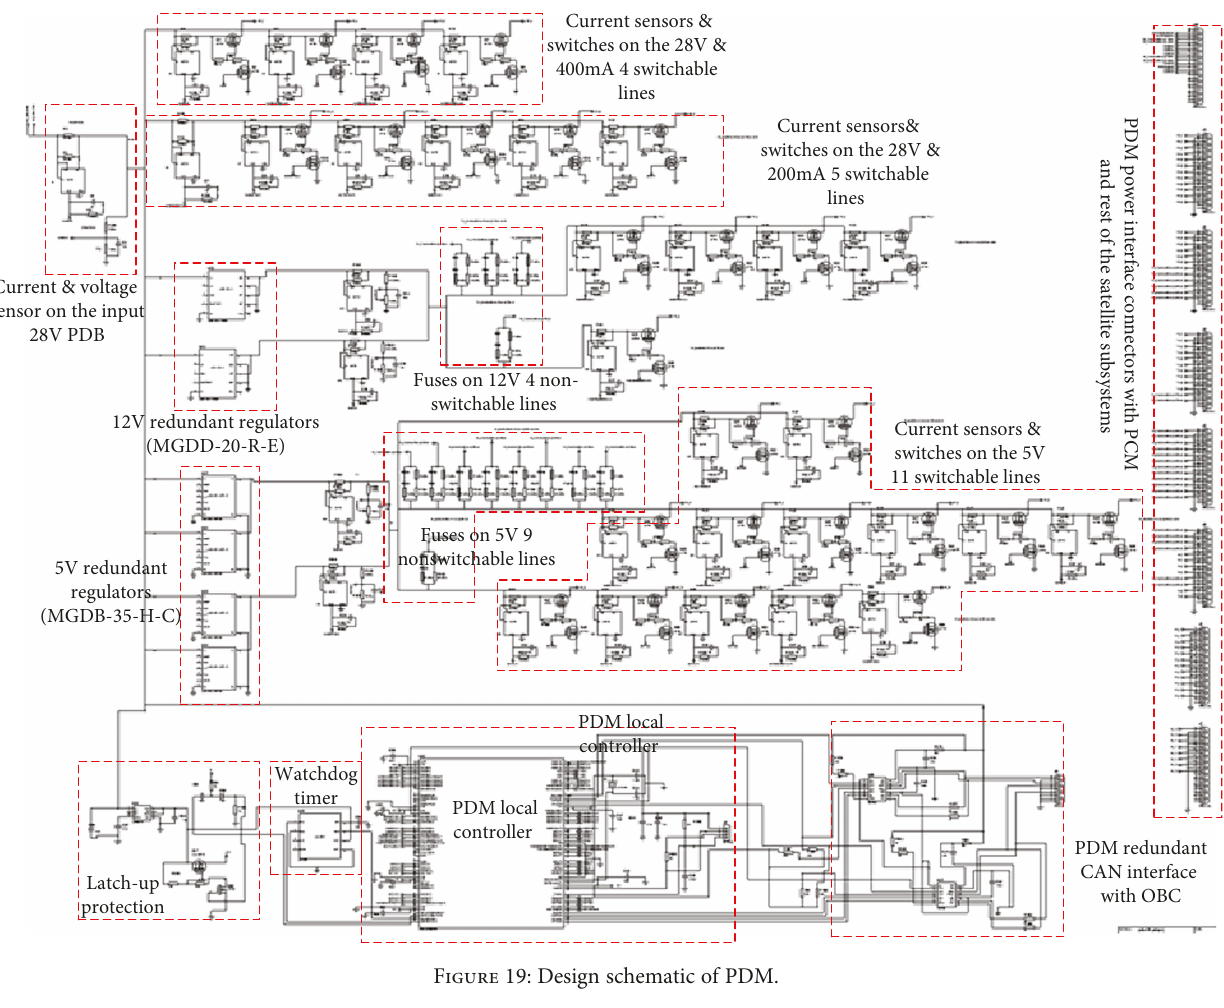
Table 3: Voltage distribution of switchable/nonswitchable lines. S. no